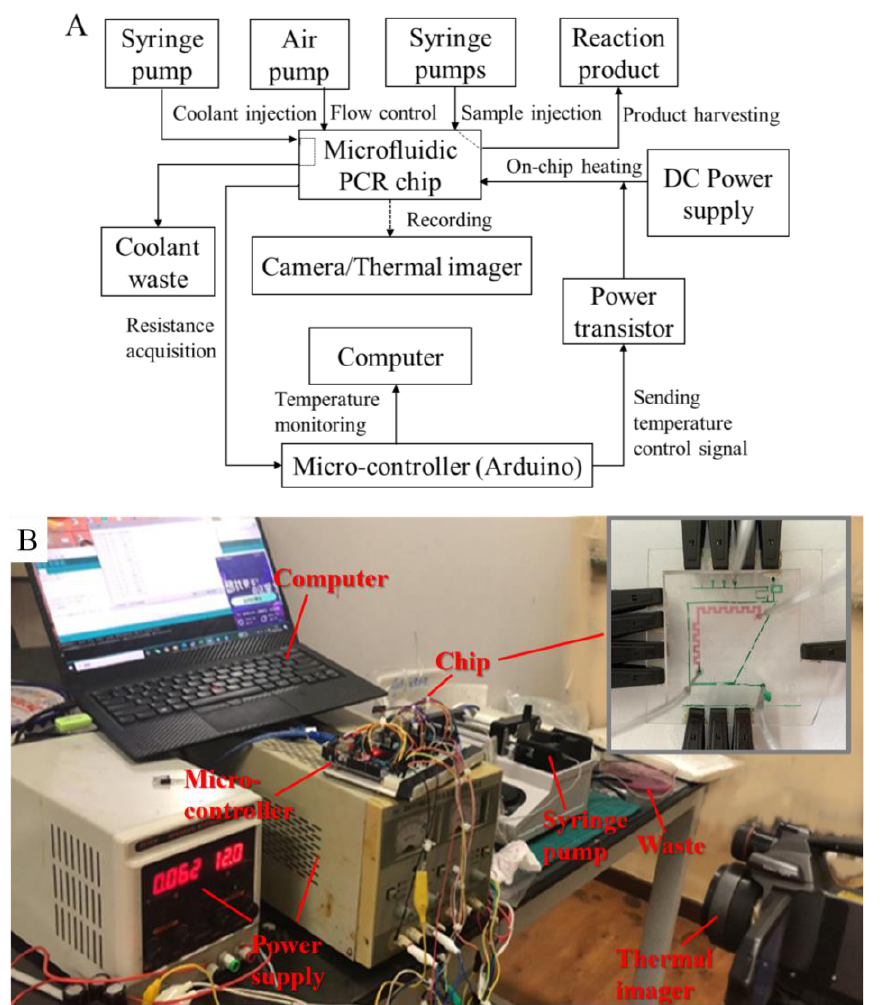
Figure 1. Control system and supporting devices for the microfluidic chip. ( A ) Diagram of the control system; ( B ) picture of experimental setup (Subfigure: Microfluidic chip with wires and tubing in tests).